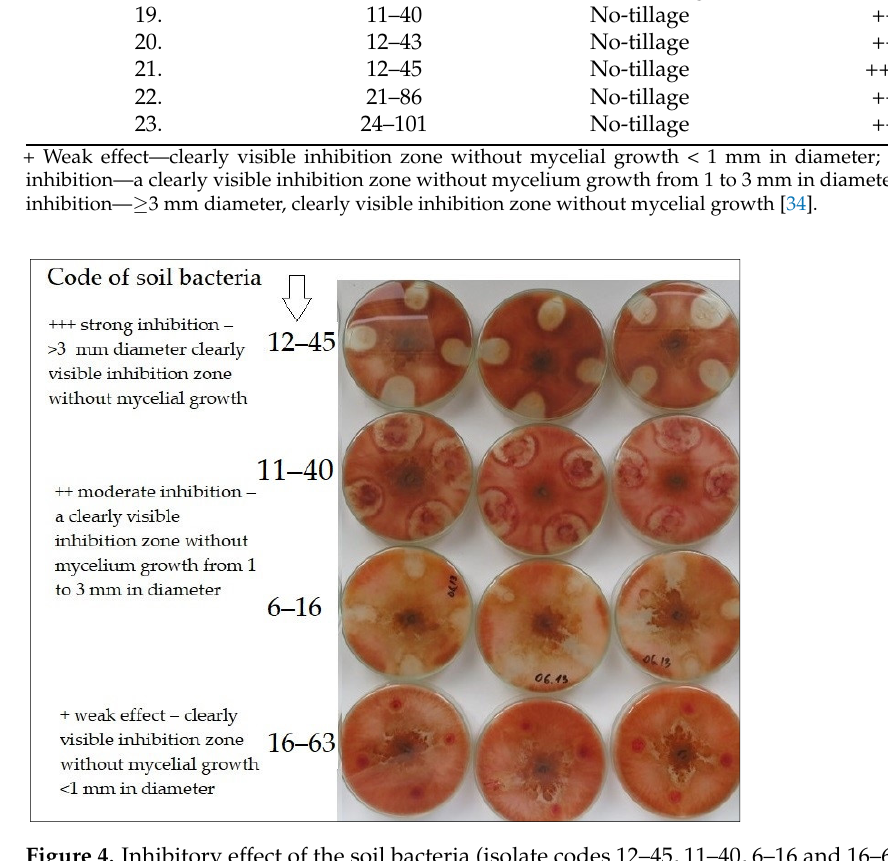
Figure 4. Inhibitory effect of the soil bacteria (isolate codes 12–45, 11–40, 6–16 and 16–63) toward F. graminearum in a dual culture on potato dextrose agar plates after 5 days of incubation at 28 °C. A 5 mm agar plug of F. graminearum was inoculated on the center of PDA plate, and the bacteria were inoculated on 4 sites of the PDA plate at an equal distance from each other, 2.5 cm apart from the fungus.